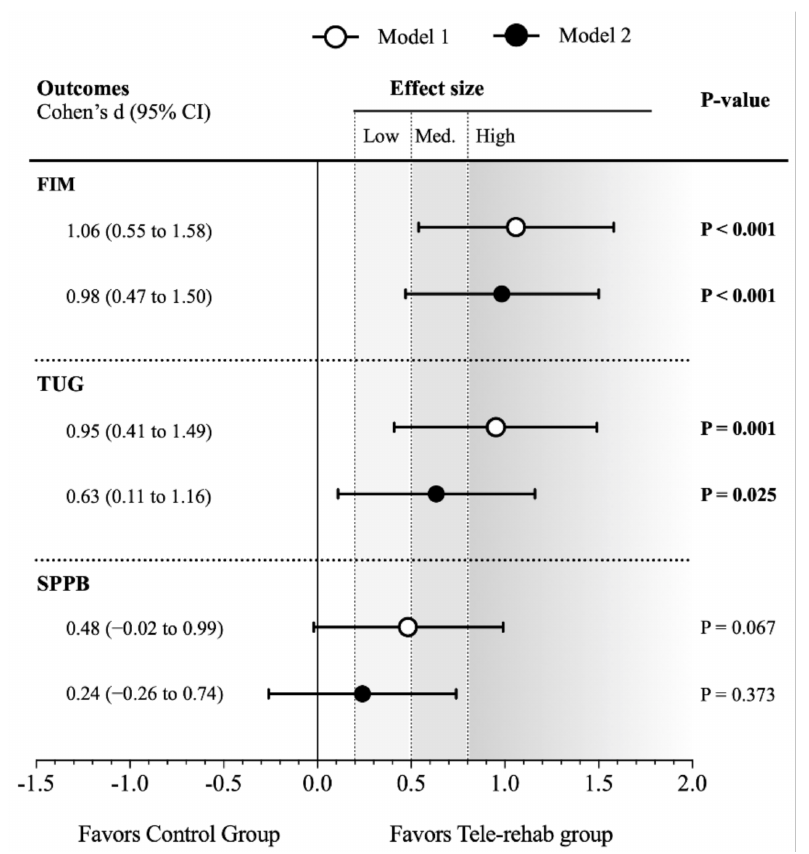
Figure 2. Effect sizes of the ActiveHip project on functional independence and physical performance in the per-protocol